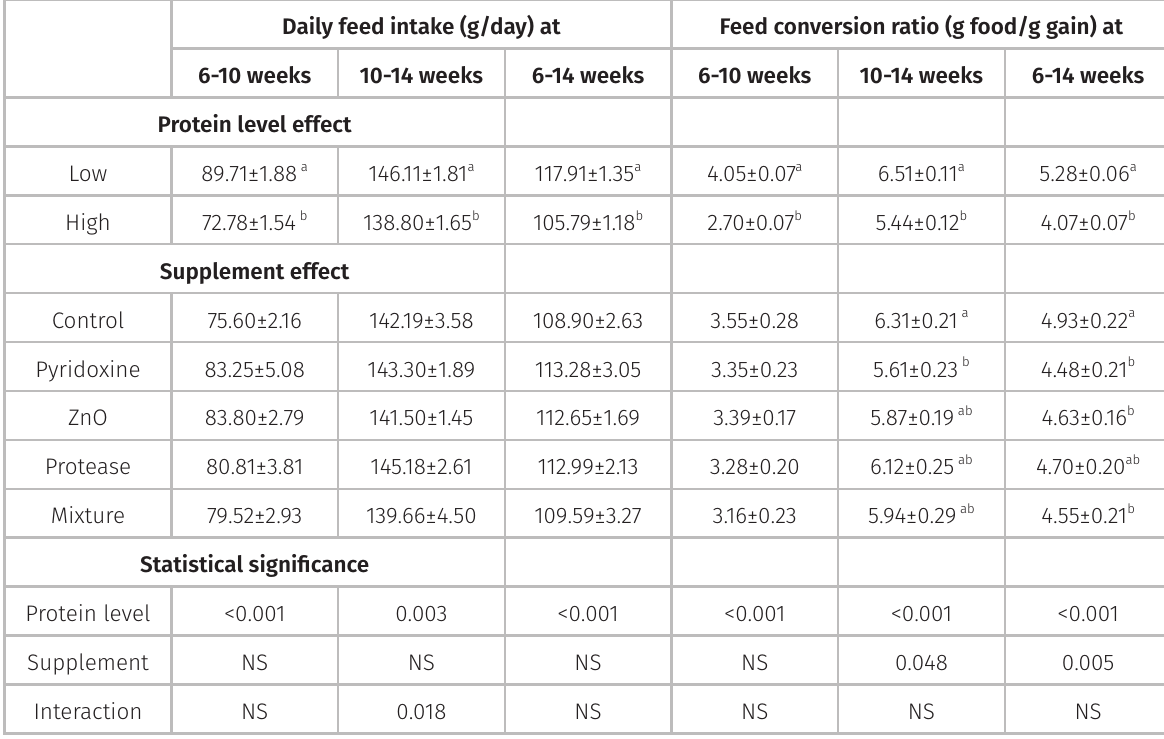
Table III. Daily feed intake and feed conversion ratio (Mean± SE) of New Zealand White rabbits as affected by protein level and tested feed